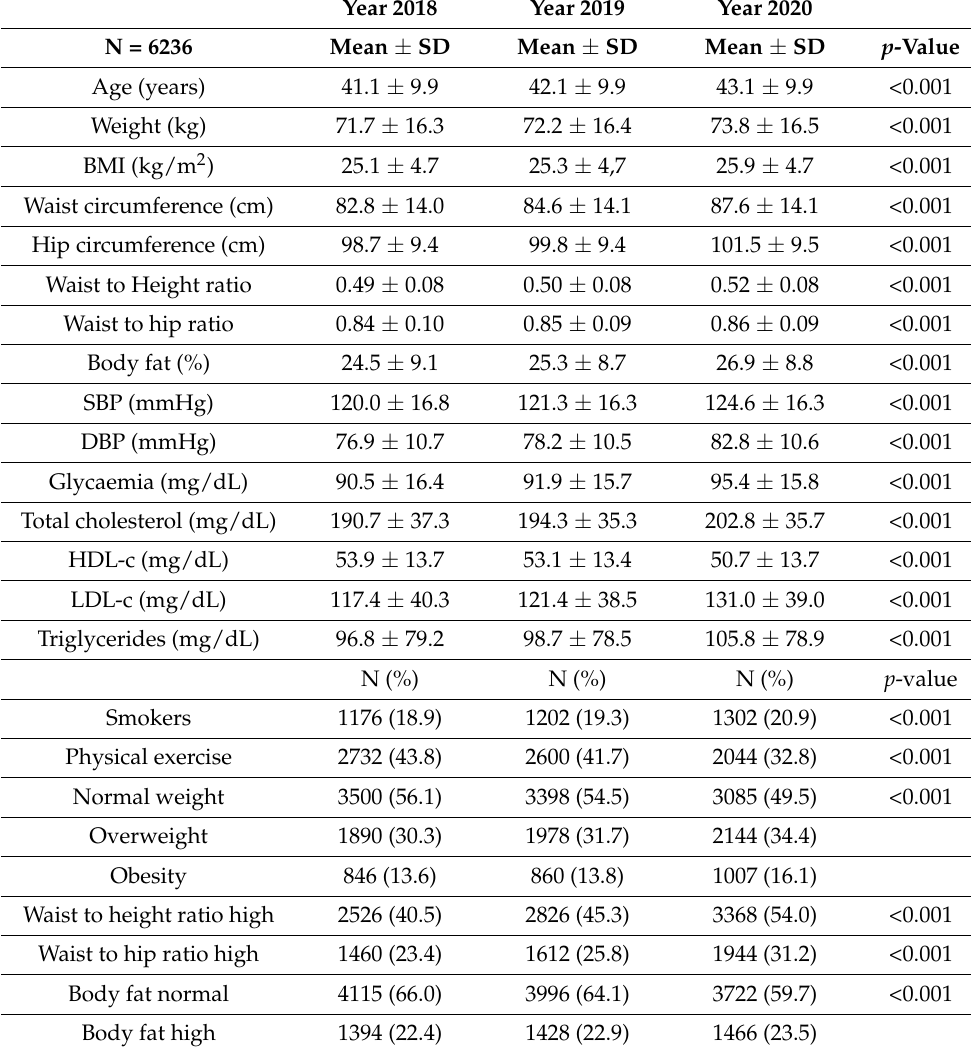
Table 1. Characteristics of the